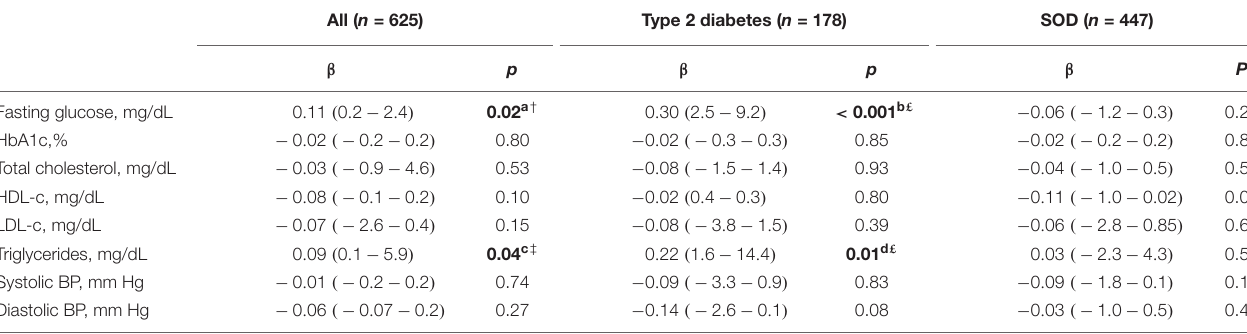
TABLE 3 | Associations of social jetlag with delta difference of metabolic parameters and BP over 1-year follow-up ( n = 625). All ( n =